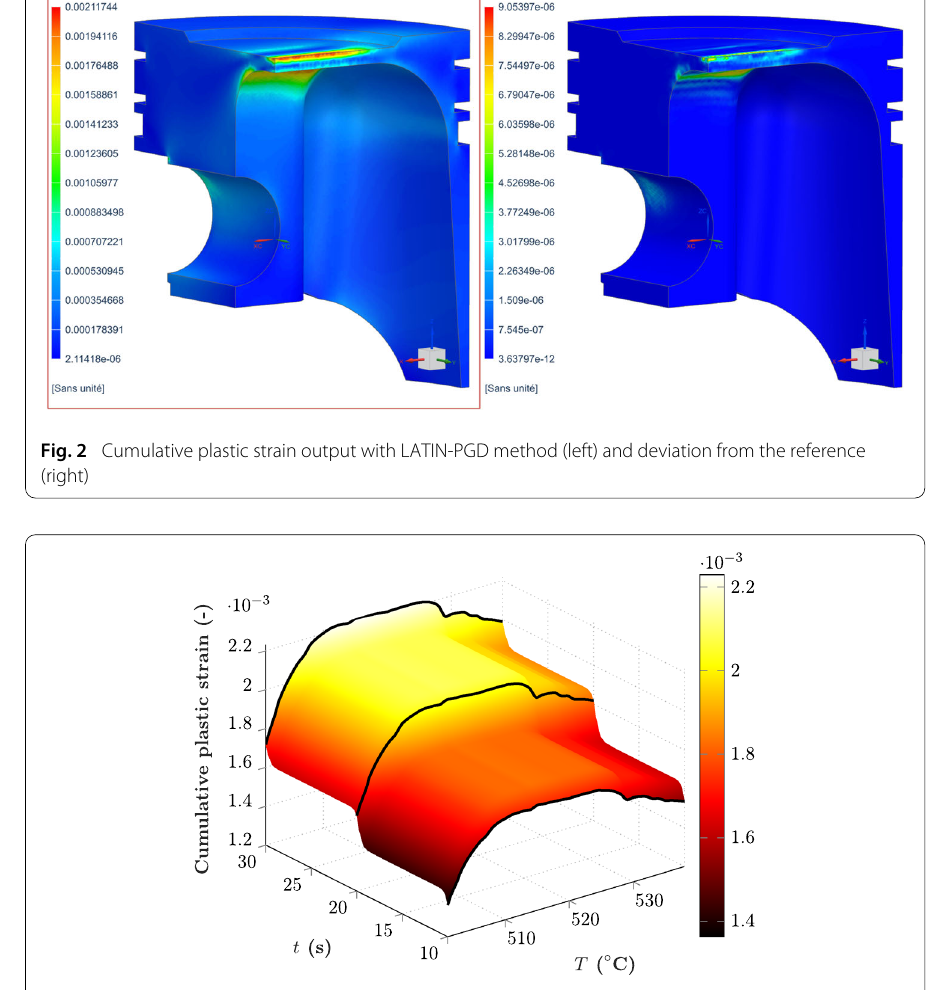
Fig. 3 Temporal evolution of the equivalent cumulative plastic strain according to temperature T for the most loaded